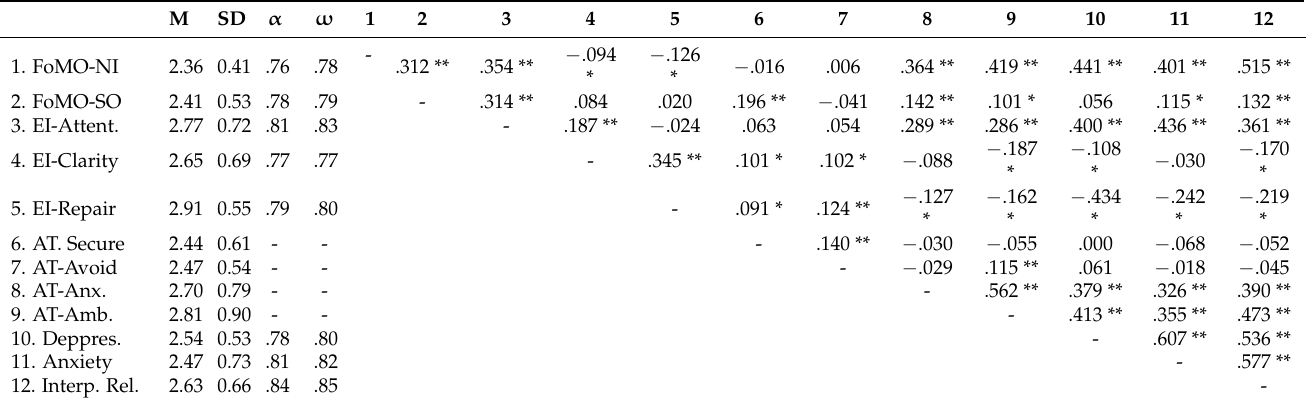
Table 3. Relationships between FoMO, emotional intelligence, attachment and psychological symptoms.